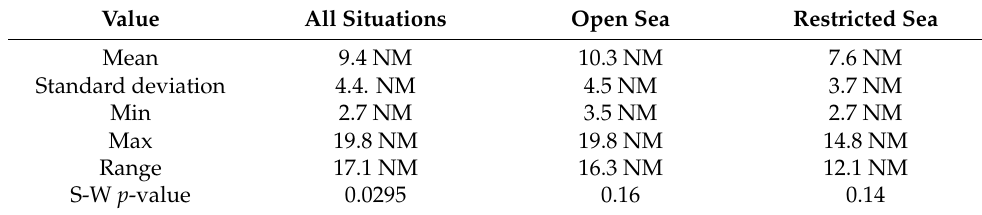
Table 2. Basic statistics for the distance between ships at the start of the